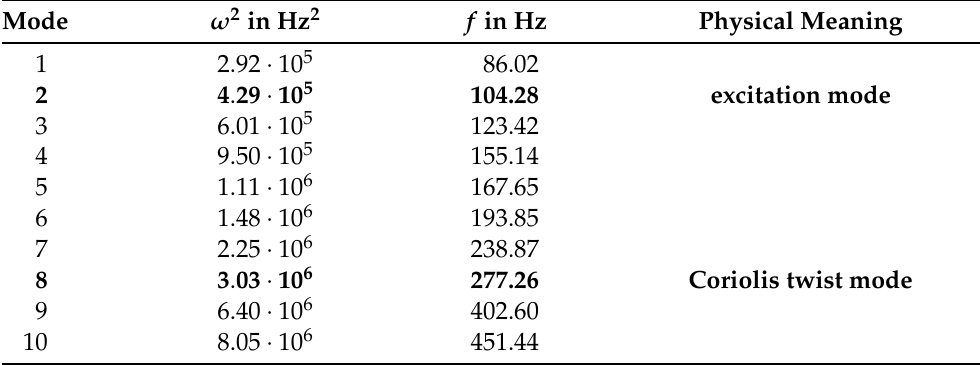
Table 4. First ten Eigenfrequencies of the modal analysis and their physical meaning.